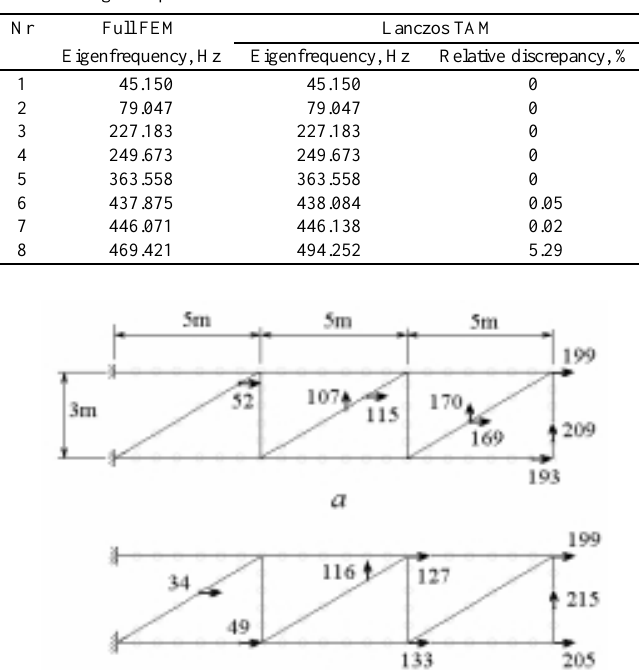
Table 1 Eigenfrequencies from the full FEM and the Lanczos TAM